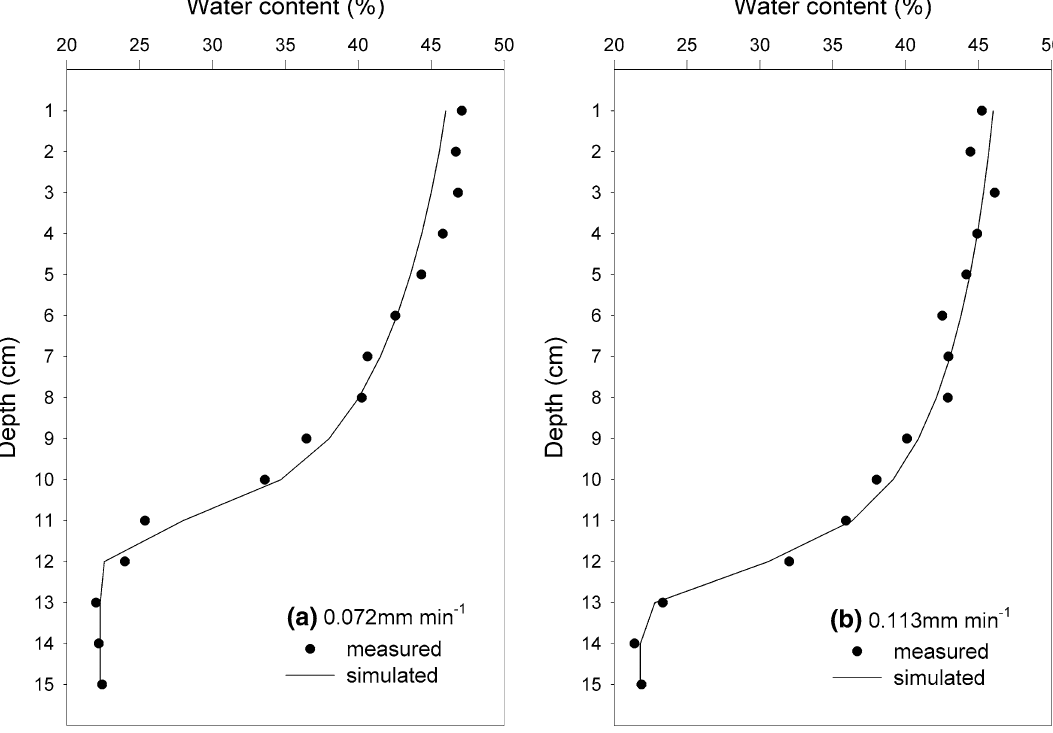
Fig. 5 Comparison of model results with the experimental soil moisture content for two natural rainfall